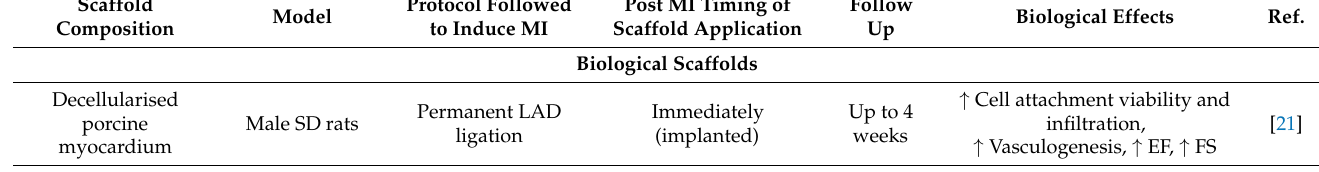
Table 1. Summary of non-functionalised acellular scaffolds to treat post-MI damage in pre-clinical and clinical models. Protocol Followed Post MI Timing of Scaffold Model to Induce MI Scaffold Application Composition Biological